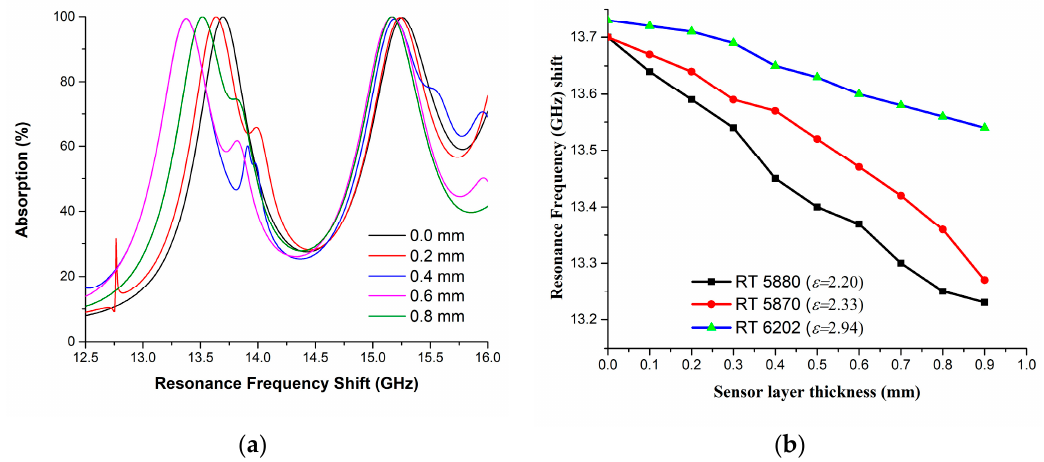
Figure 11. Unit cell absorber for pressure sensitivity in simulation ( a ) Absorption (%) amount and Resonance frequency shift w.r. to sensor layer thickness ( b ) Sensor layer relationship with Resonance frequency.